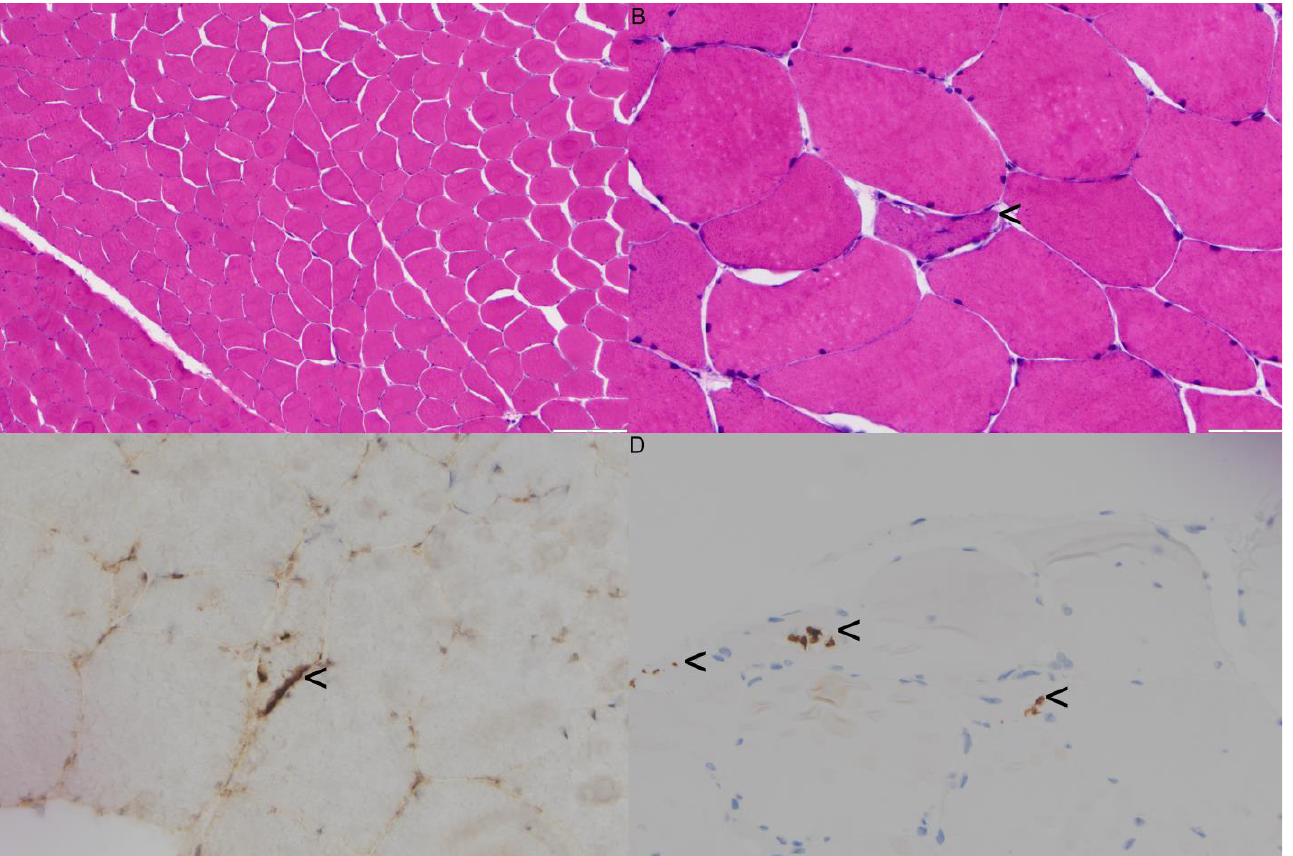
Figure 5. Biopsy findings for proband 3 (III:3). ( A ) Representative low-power magnification of an H&E-stained cryosection of skeletal muscle demonstrating fascicular architecture with mild myofiber size variation without definite endomysial fibrosis, fatty replacement, perimysial pathology, vasculitis, inflammatory or necrotizing myopathy, or perifascicular atrophy/necrosis. Rare areas with marked myofiber atrophy and very rare degenerating myofibers were also noted (not shown). ( B ) High power magnification of the same H&E-stained section as seen in ( A ) showing an atrophic fiber with mildly basophilic sarcoplasm with subsarcolemmal rimmed clefts/defects with granular eosinophilic material (rimmed vacuoles) (black arrowhead). ( C ) High-power magnification of a TDP43 immunohistochemical (IHC) stain performed on a cryosection demonstrating subsarcolemmal aggregates (black arrowhead). ( D ) Phospho-TDP43 (Ser409/Ser410) (1D3) IHC stain on formalin-fixed paraffin embedded (FFPE) tissue showing staining compatible with sarcoplasmic aggregates and rimmed vacuoles (black arrowheads).